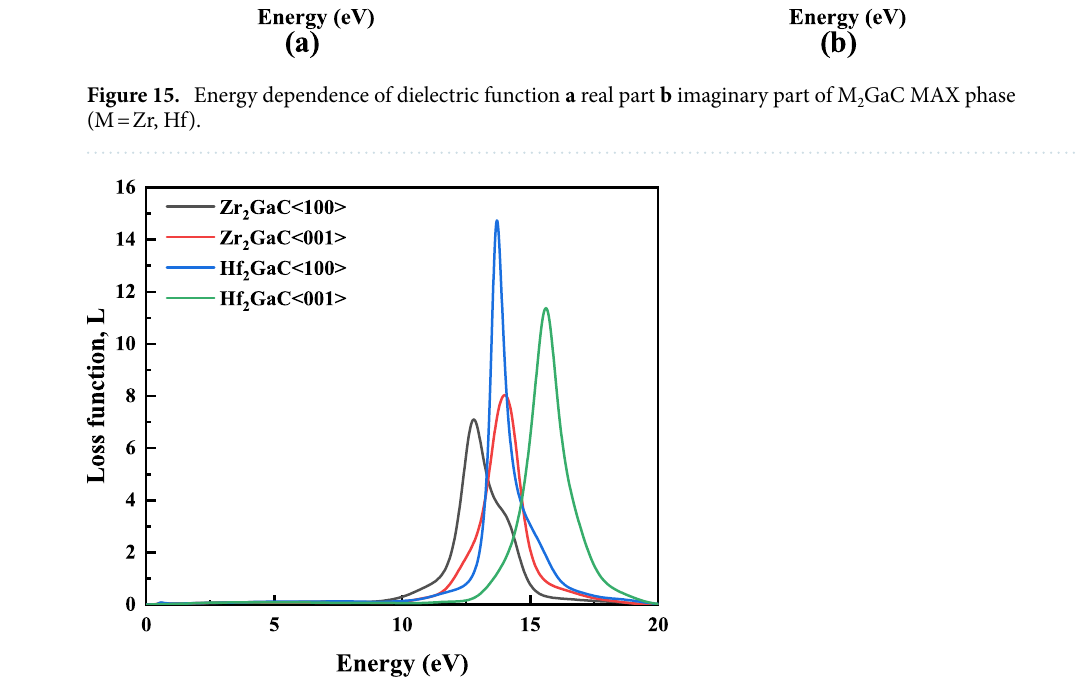
Figure 16. Loss function of M 2 GaC MAX phase (M = Zr, Hf) for <100> and <001>